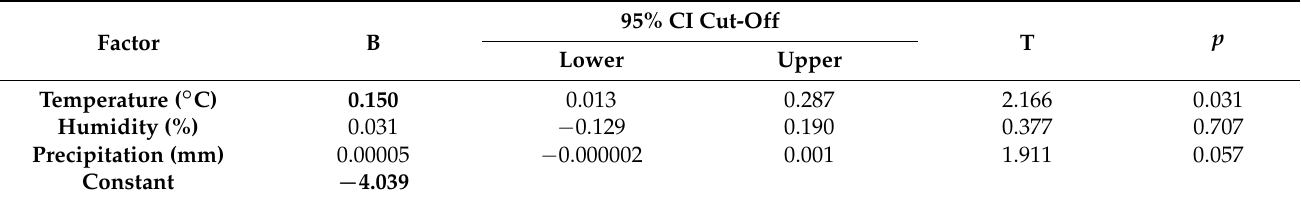
Table 4. Association between the number of cases of leishmaniosis from 1945 to 2014 in Montenegro and yearly values of meteorological factors (air temperature, humidity, and